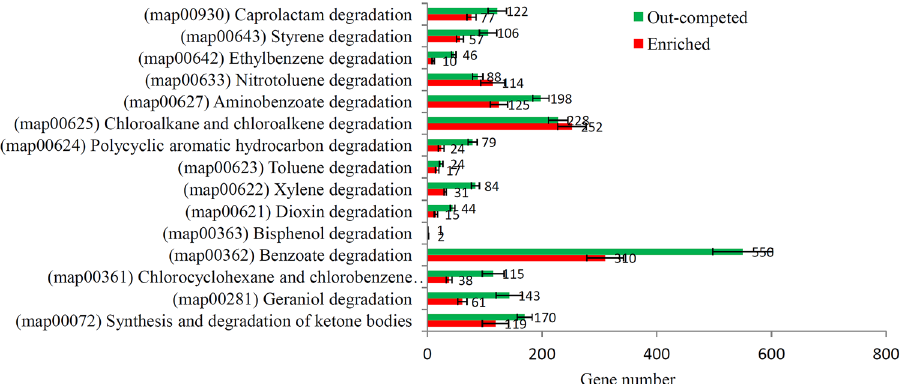
Figure 3. Analysis of xenobiotic biodegradation pathway-related KEGG terms. The number of enriched and out-competed genes related to xenobiotic biodegradation pathways after